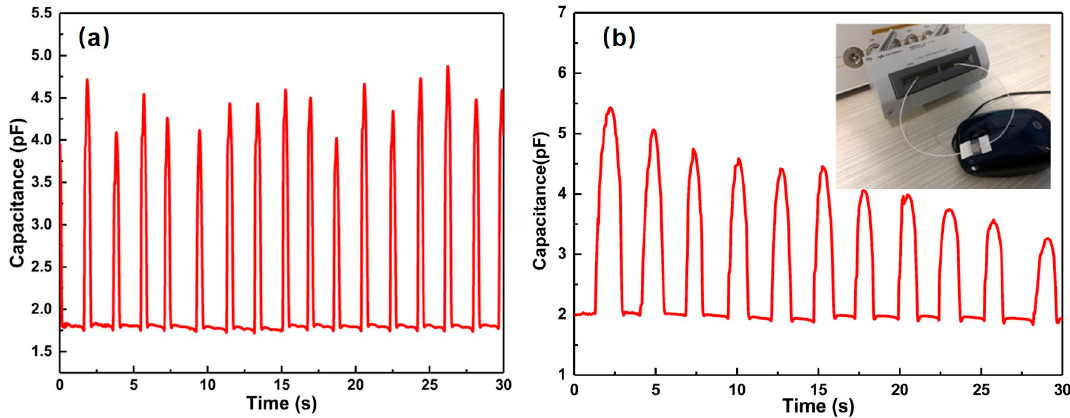
Figure 8. Mechanical mouse test ( a ) quick mouse response; ( b ) normal speed response of mouse. Sensors 2020 19 , x